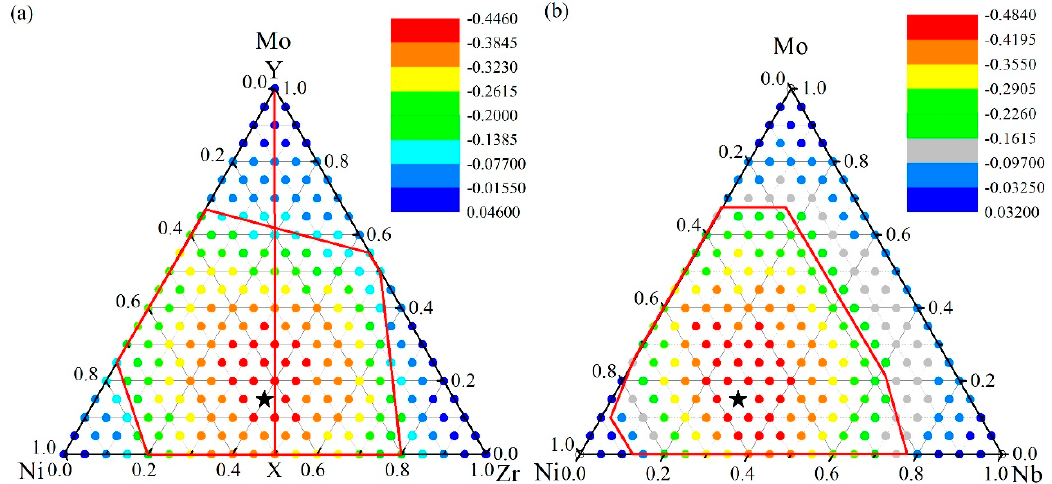
Figure 6. The formation energy difference between the solid solution and amorphous phase for ( a ) Ni-Zr-Mo system [56], and ( b ) Ni-Nb-Mo system [55]. The quantitative energy scale for dots with different colors are presented for the respective systems.